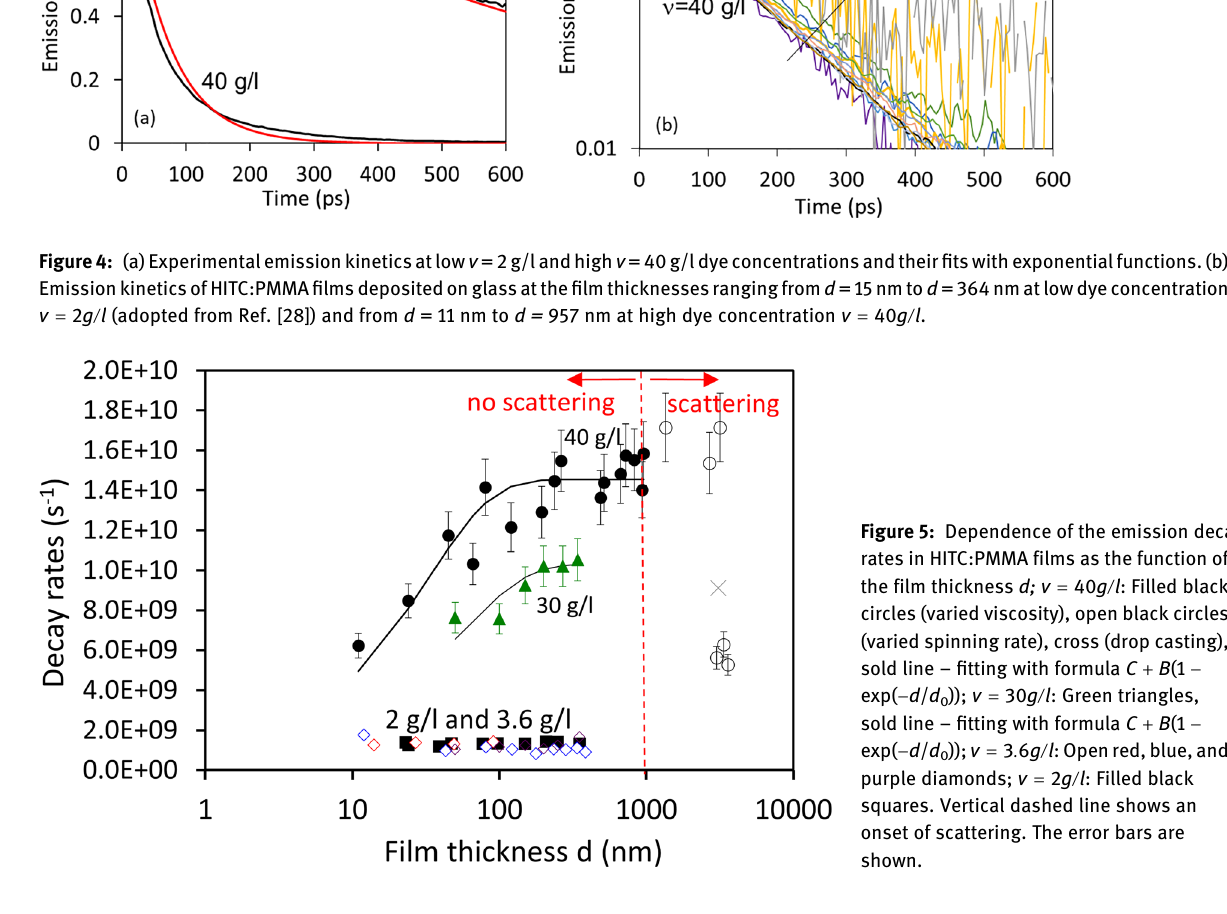
Figure 5. A qualitatively similar behavior (and the fi tting) have been demonstrated in the series of HITC:PMMA fi lms with dye concentrations equal to ν = 30 g / l , green triangles in Figure 5.